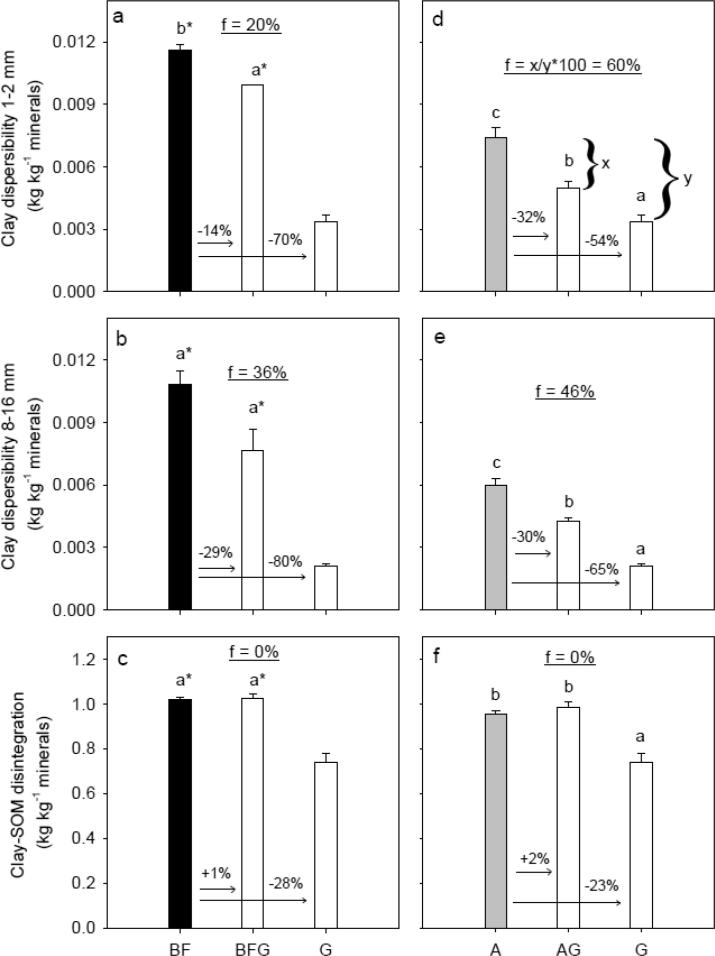
Restoration scenarios: Management system effects on clay dispersibility of 1–2 mm aggregates rewetted to −100 hPa, clay dispersibility of 8–16 mm aggregates rewetted to −100 hPa, and clay-SOM disintegration (the ratio between clay particles retrieved without SOM removal and with removal). White, gray and black bar fills highlight treatments grass, arable and bare fallow, respectively, at time of sampling. Letters denote statistical significance at P < 0.05. An asterisk (*) indicates if G is significantly different from BF and BFG based on a pairwise t-test. The numbers above the arrows denote relative differences. The underlined number in the middle part of the figures denotes the difference after six years in relation to the long-term difference, and an example of the calculation is shown in Fig. d. For treatment abbreviations, see Fig. 1.